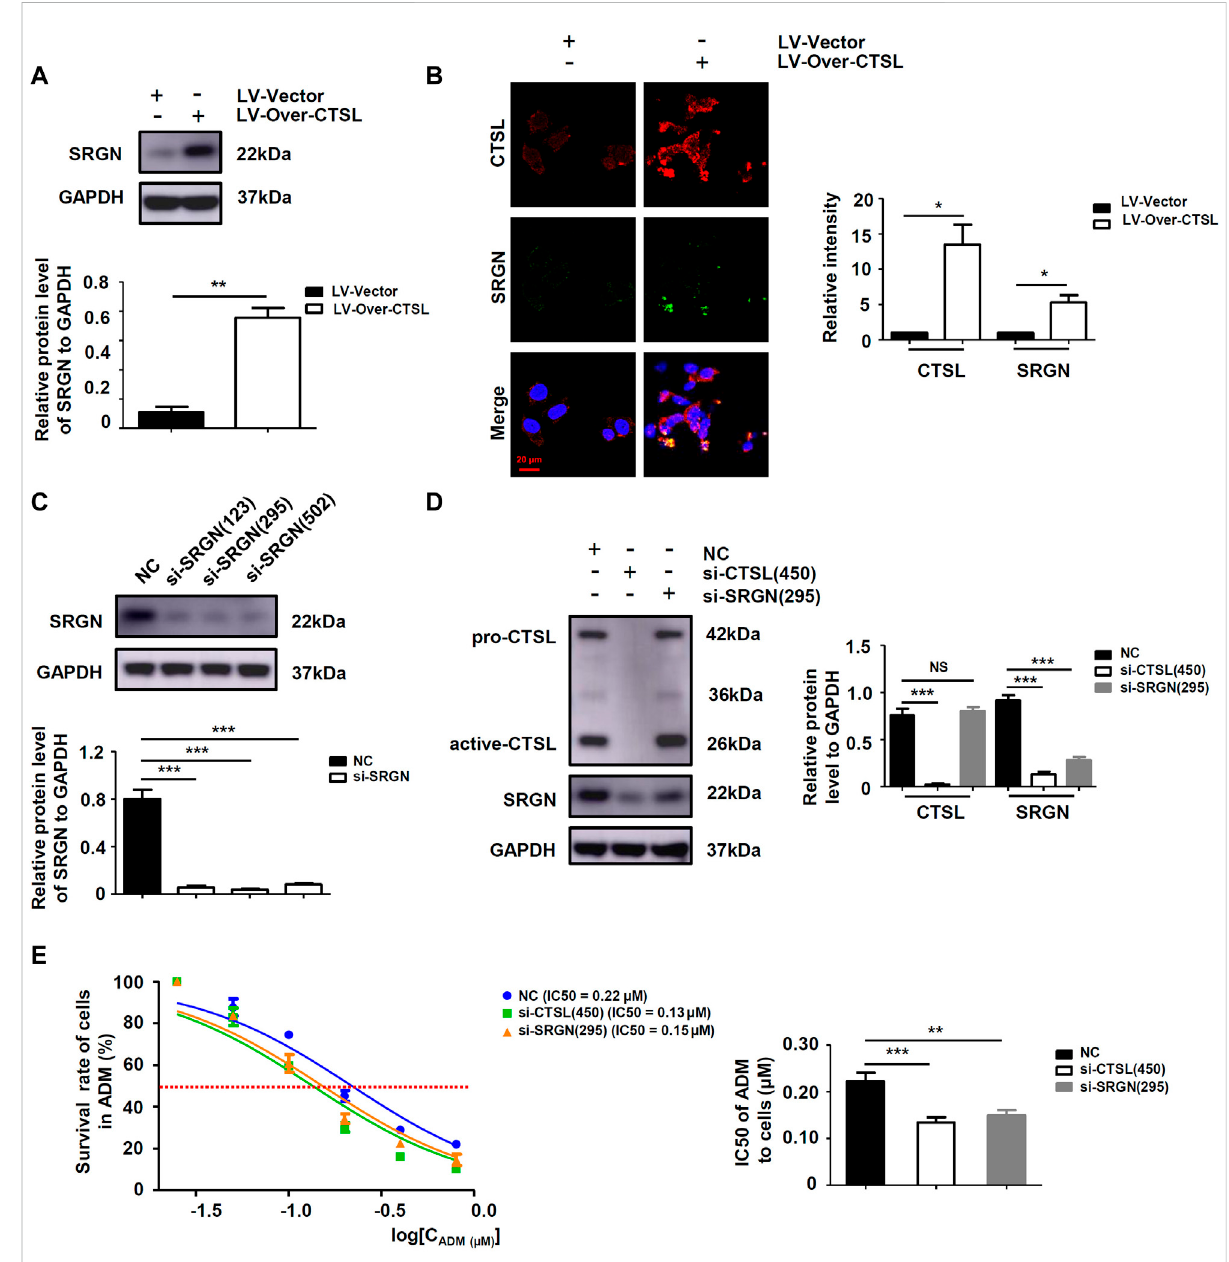
FIGURE 7 SRGNwas akeyprotein for CTSL mediatedchemoresistance inNB cells (A) WesternblotanalysisofSRGN levels inIMR-32/LV-Vector cellsand IMR-32/LV-Over-CTSL cells (B) Immuno fl uorescence assay showing the expression and intracellular location of CTSL and SRGN in IMR-32/LV- Vector cells and IMR-32/LV-Over-CTSL cells. Nuclei were counterstained with DAPI (red bar: 20 μ m) (C) and (D) Western blot showing SRGN expression in IMR-32/LV-Over-CTSL cells after SRGN silencing or CTSL silencing (E) Cell viability curves for IMR-32/LV-Over-CTSL cells after si-CTSL (450), si-SRGN (295), and ADM treatment were evaluated using the Cell Counting Kit-8 assay (left panel). The IC50 values were analyzed using the Mann-Whitney test (right panel). NS: not statistically signi fi cant, *, p < 0.05, **, p < 0.01, ***, p <